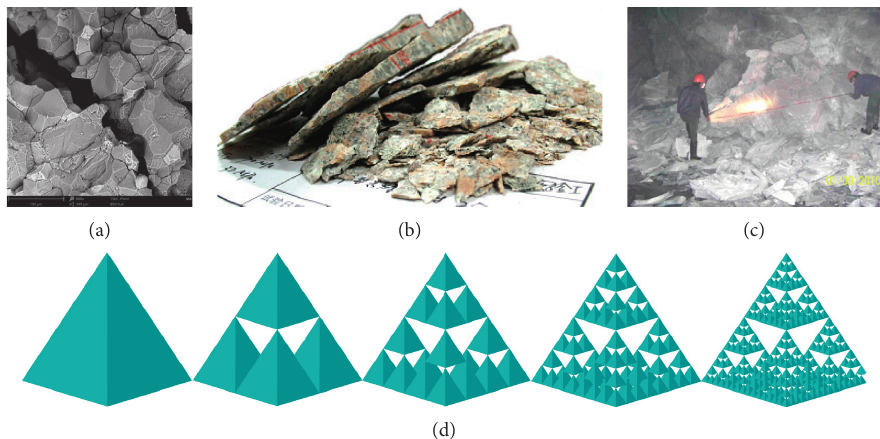
Figure 2: Fractal characteristics of rockbursts at different scales: (a) microcracking indicated by SEM image [32], (b) fragmentation distribution of rockburst sample fragments [17], (c) fragmentation distribution of the ejected fragments of an in situ rockburst [33], and (d) illustration of rockburst fracturing process with the Sierpinski